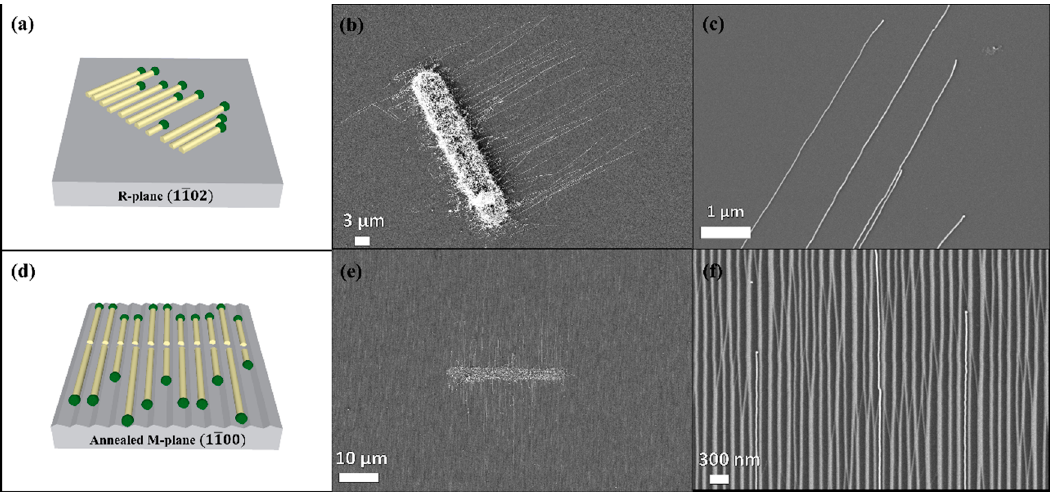
Figure 1. Guided VLS growth of surface-guided GaN nanowires (NWs). Schematic illustration of planar NWs on ( a ) R-plane and ( d ) annealed M-plane sapphire substrate. SEM images of planar GaN NWs grown on ( b , c ) flat R-plane sapphire substrate and on ( e , f ) faceted annealed M-plane sapphire substrate.